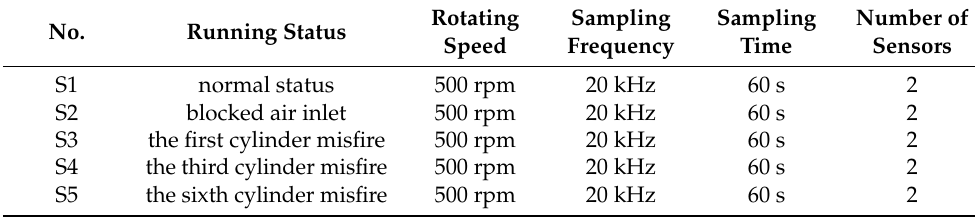
Table 1. Sampling settings for diesel engine preset states